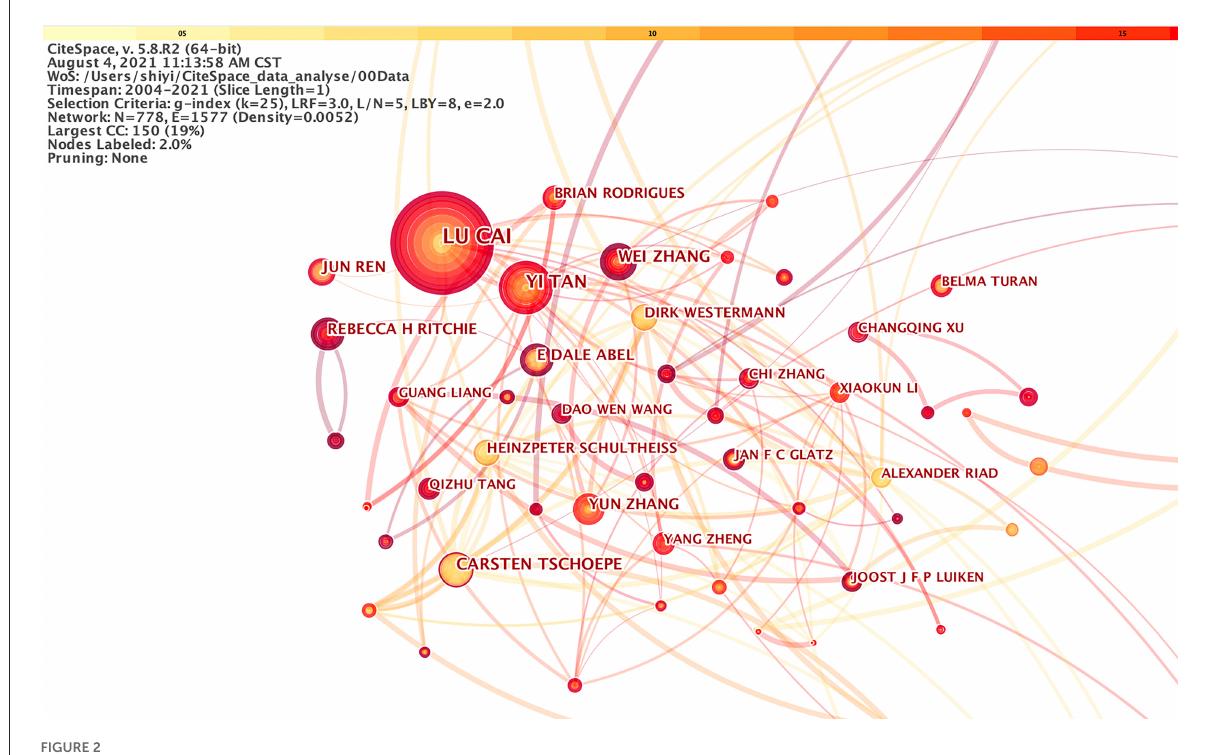
FIGURE2 The cooperation network of productive authors.